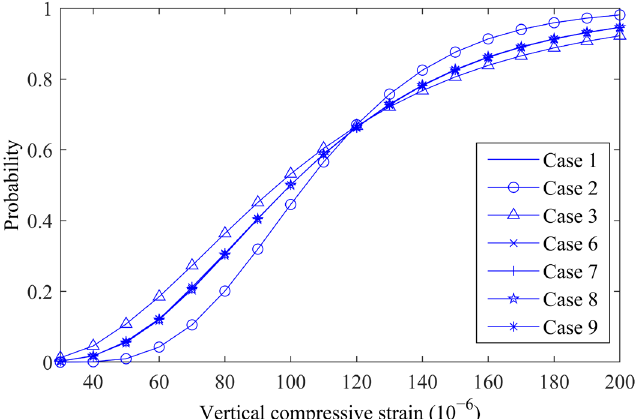
Figure 9. Results of the cumulative probability distributions of vertical compressive strain at B1 with the different standard deviations of load pressure, speed, and temperature of the asphalt layer.